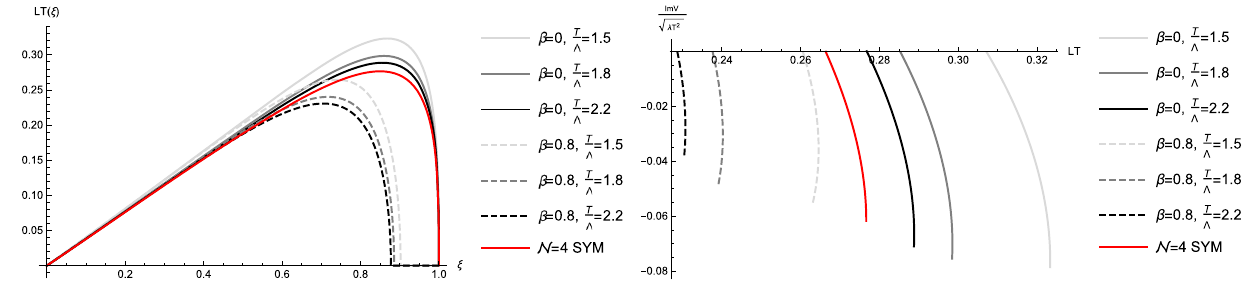
√ / λ T versus LT for different values of QQ